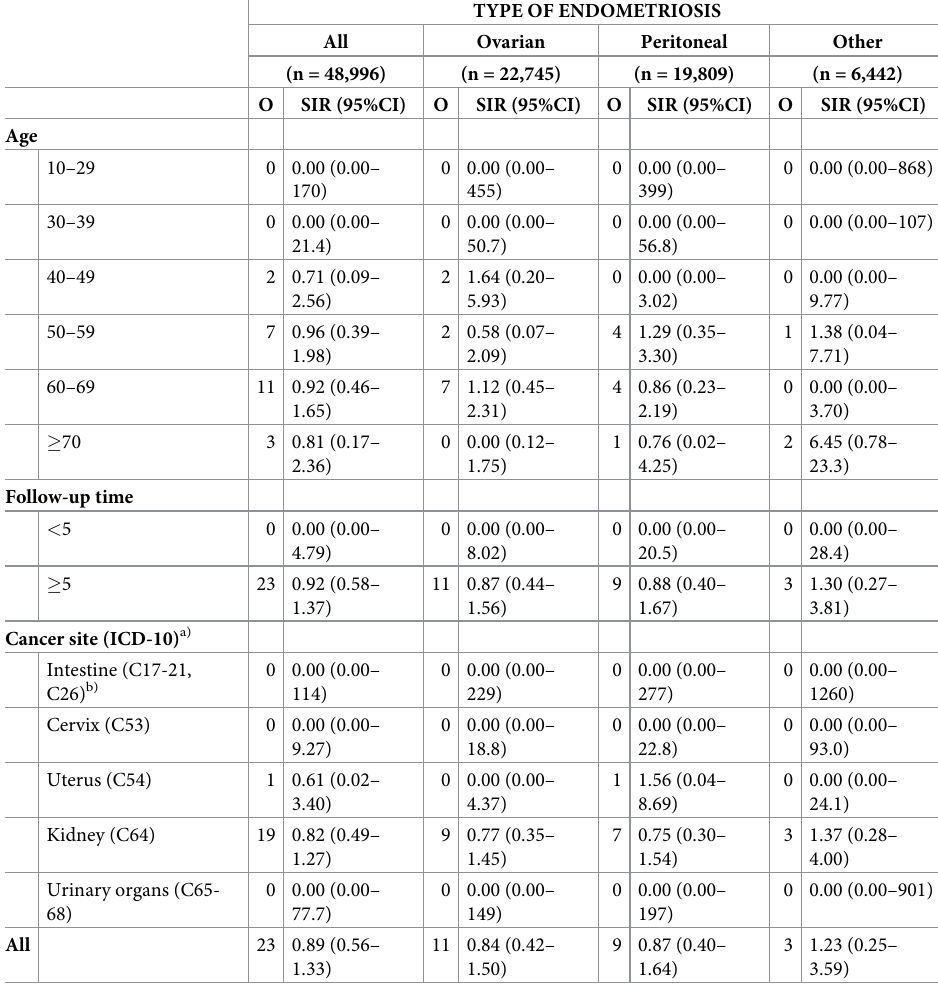
Table 2. Extraovarian clear cell cancers among women with surgically diagnosed endometriosis according to the type of endometriosis by age (years), follow-up time (years) and cancer site. Observed number of cancer cases (O), standardized incidence ratio (SIR) and 95% confidence interval